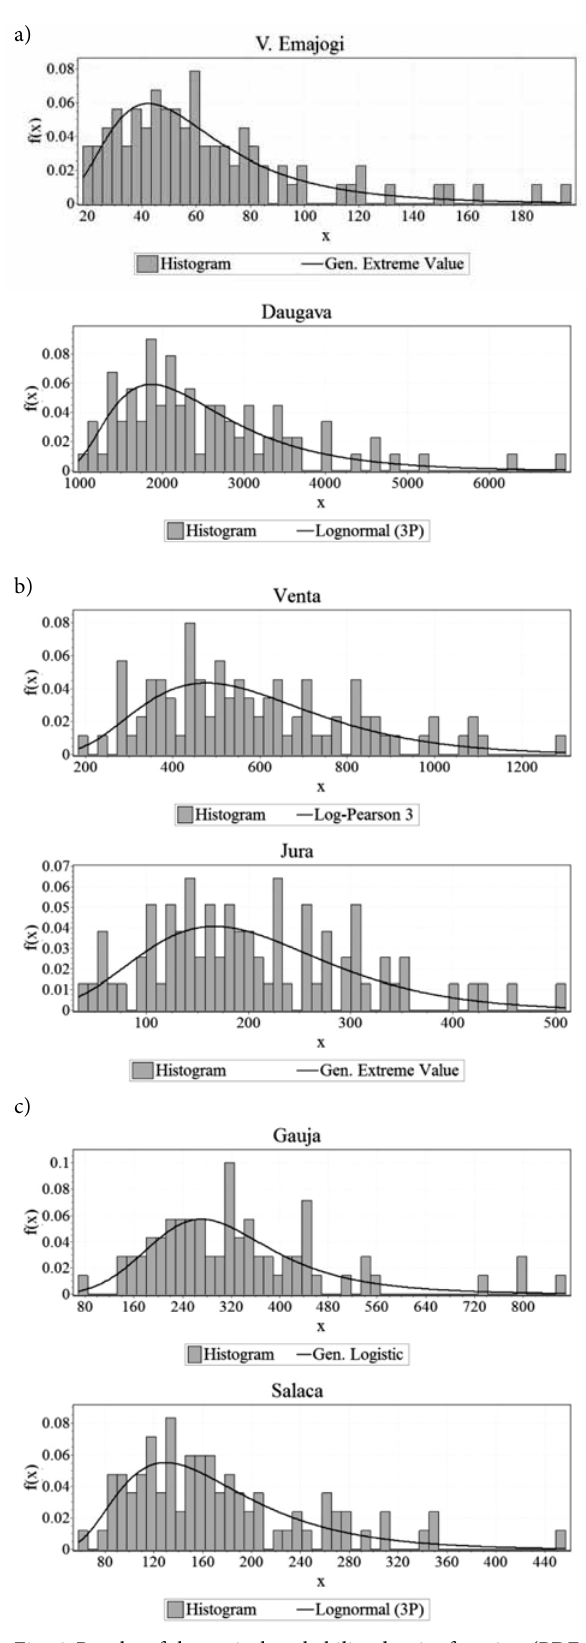
Fig. 6. Results of theoretical probability density function (PDF; displayed as a continuous curve) fitting to the empirical PDF (displayed as a histogram) for: a) continental rivers; b) marine rivers; and c) transitional rivers (in x axis – annual